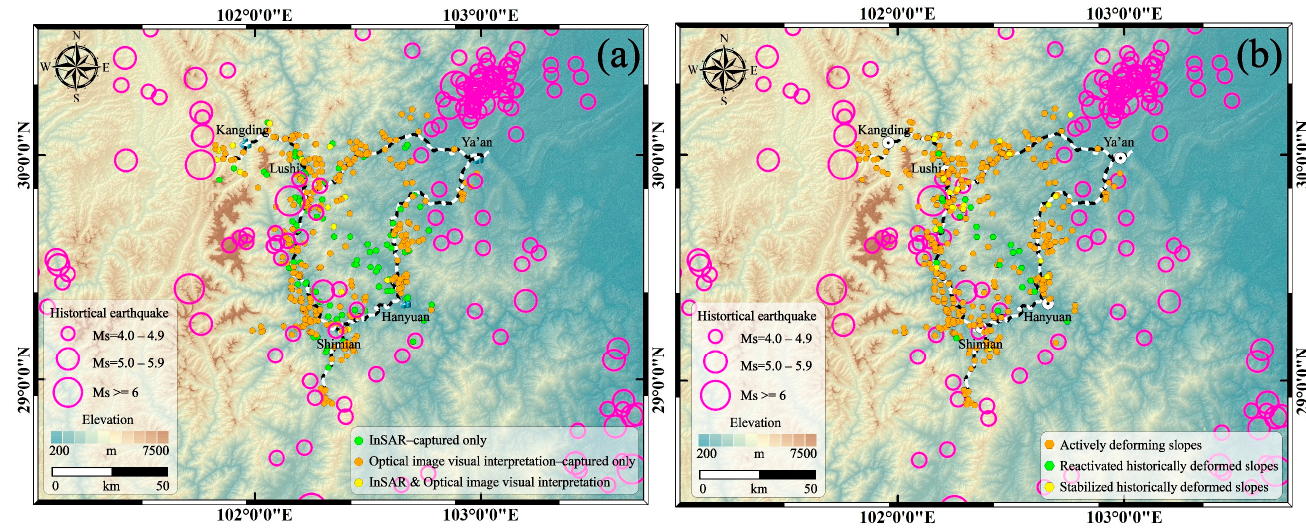
Figure 7. Distribution of landslides along the three expressways in Sichuan Province, China detected by multi-temporal satellite optical images and GACOS-assisted InSAR stacking. ( a ) Distribution map of landslides detected by different methods, and ( b ) distribution map of actively deforming slopes (I), reactivated historically deformed slopes (II), and stabilized historically deformed slopes (III). Pink circles indicate historical earthquakes that occurred during the period from 1900 to 2021, collected from the United States Geological Survey.